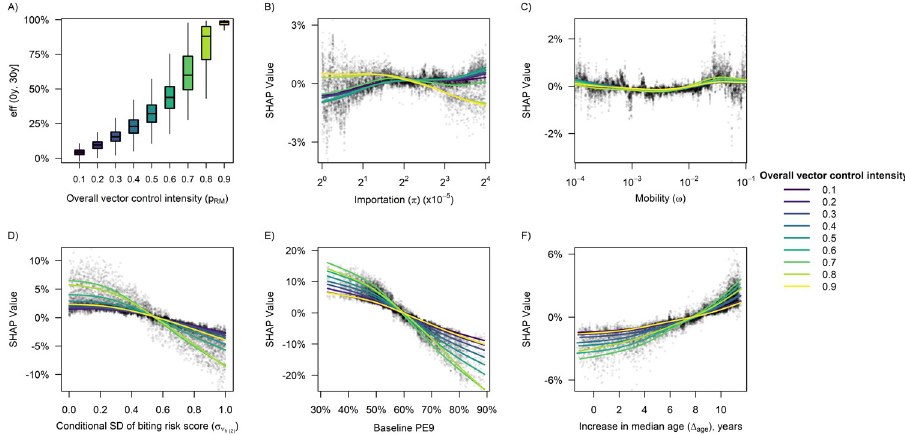
Fig 5. Impact of different predictor variables on the vector control effectiveness across the entire 30-year intervention period. For (A), the original values of the intervention effectiveness obtained from the simulation runs were summarized. Each box was drawn from the first quartile (Q1) to the third quartile (Q3) of the data, with the horizontal line in the middle showing the median. The upper whisker boundary was the largest observation that was within Q3 + 1.5 � (Q3—Q1), and the lower whisker boundary was the smallest observation above Q1–1.5 � (Q3—Q1). Data points beyond the whisker boundaries were omitted from the graph for clarity. For (B)—(F), we used SHAP values to quantify the change in the predicted overall intervention effectiveness due to the value of each predictor variable, where each point represents a single simulation run and each curve was obtained by fitting a smoothing spline to the set of data points corresponding to a given overall level of vector control